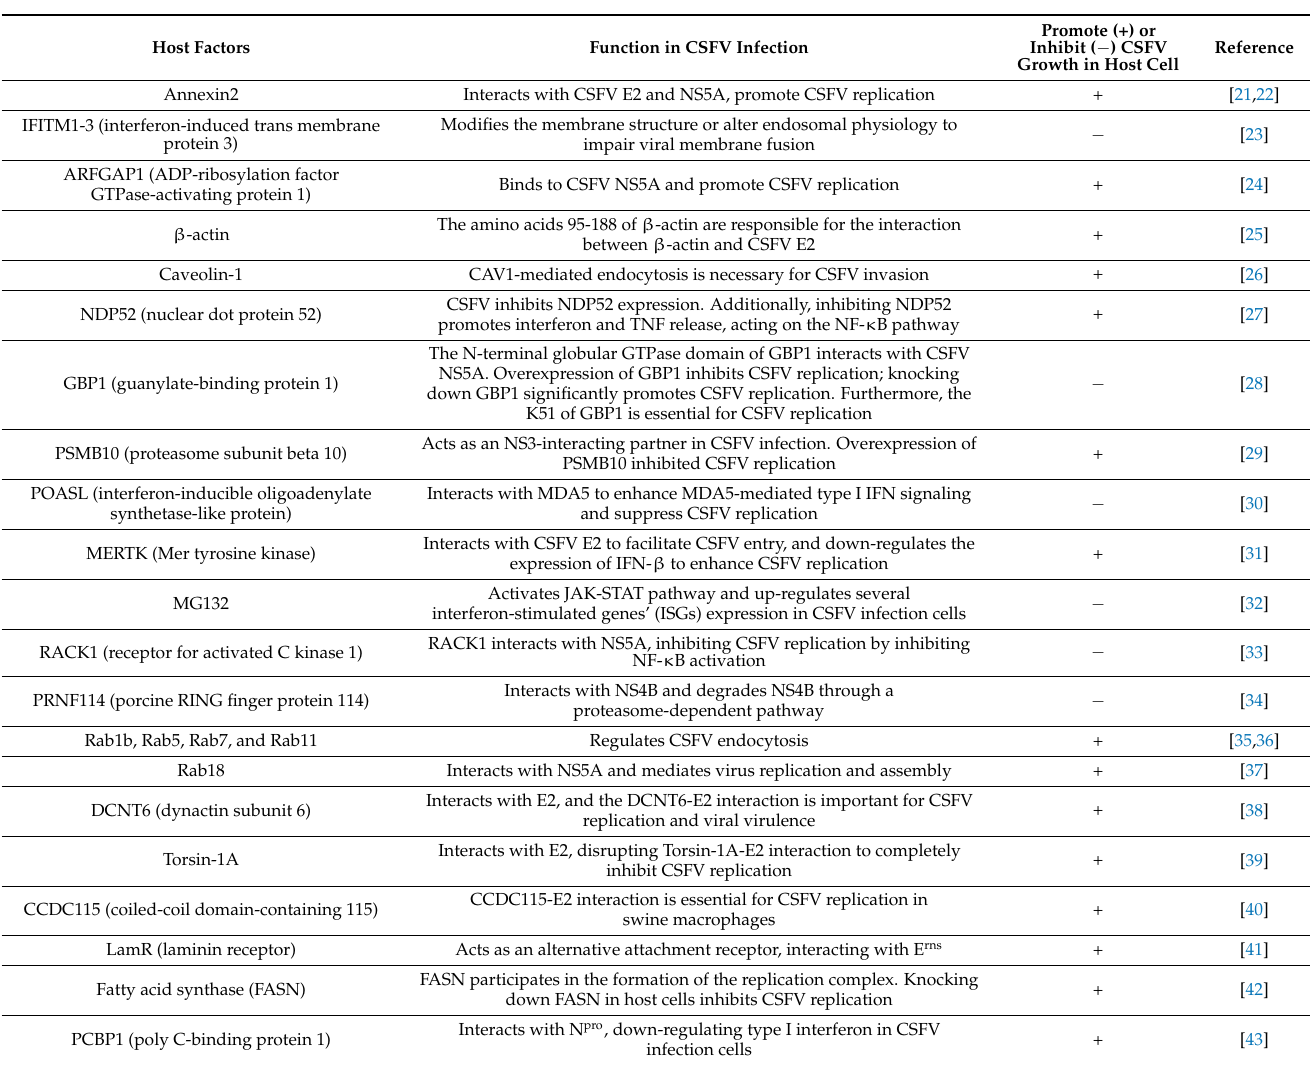
Table 1. Host factors that act in CSFV